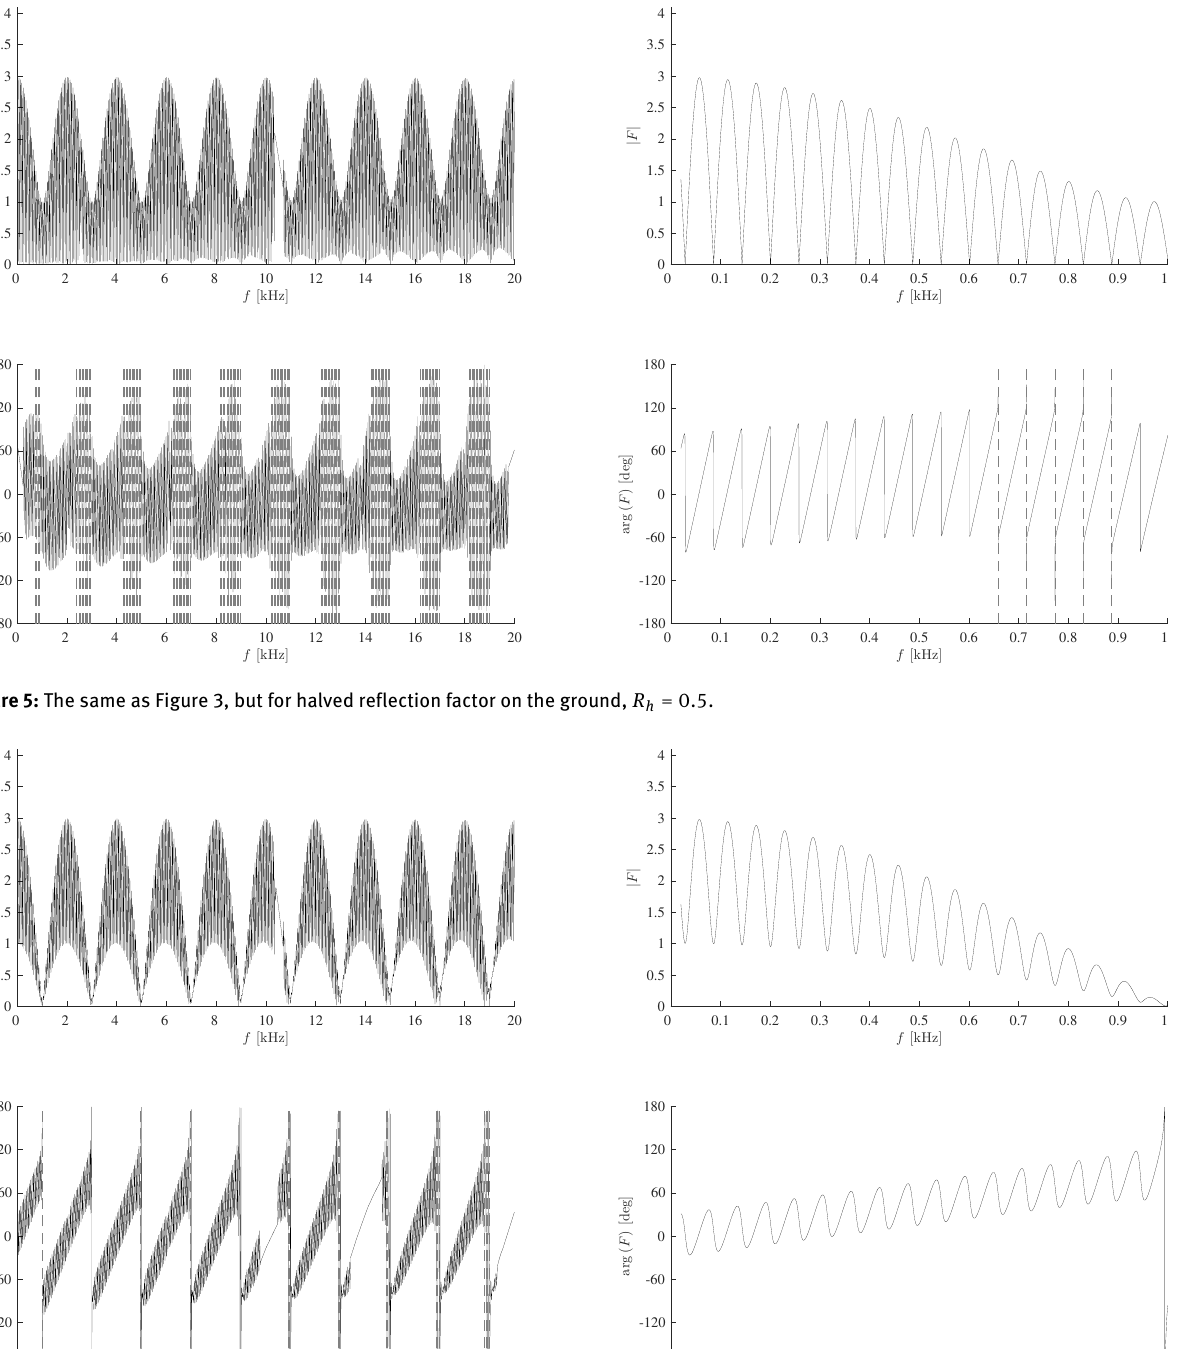
the observer position returns to the baseline position, but the ground has reflection coefficient one-half. Instead, in Figure 6, the reflection coefficient is one-half on the wall. In Figure 7, both walls have reflection coefficient one-half.